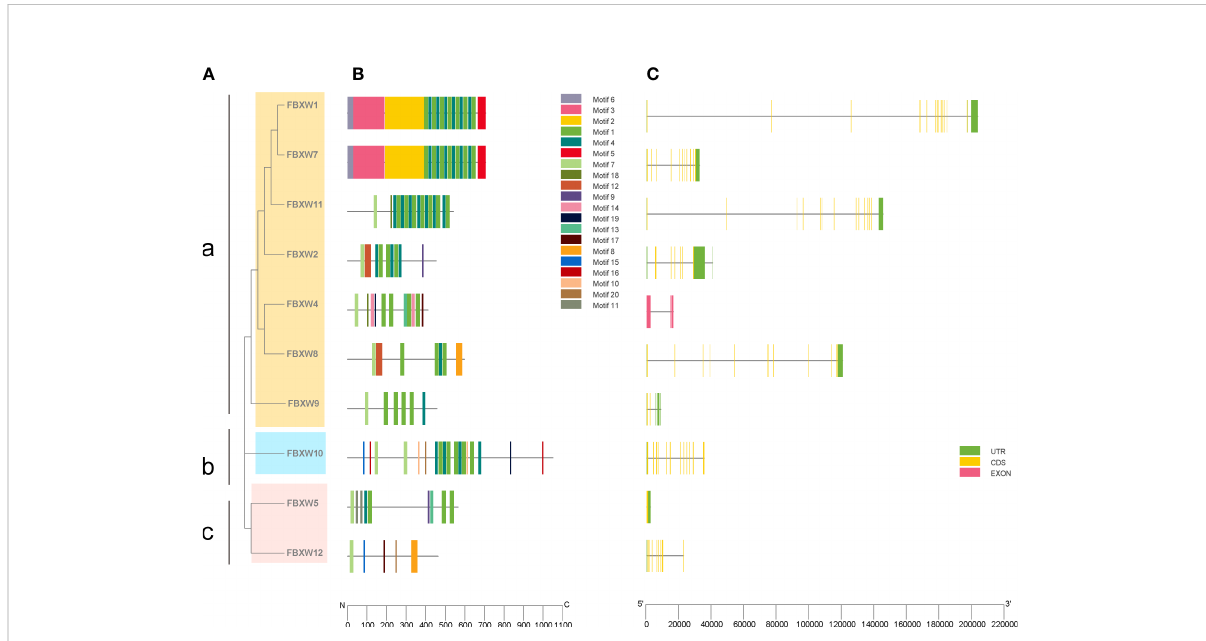
FIGURE 1 Phylogenetic relationships, conserved protein motifs and gene structures of the FBXW family members. (A) The phylogenetic tree was constructed based on the full-length sequences of Homo sapiens FBXW proteins. (B) Motifs distribution of the FBXW proteins. (C) Exon-intron structures of the FBXW genes. Green boxes indicate untranslated region; yellow boxes indicate coding sequences; pink boxes indicate exons and black lines indicate introns. a, b and c represent the three groups,